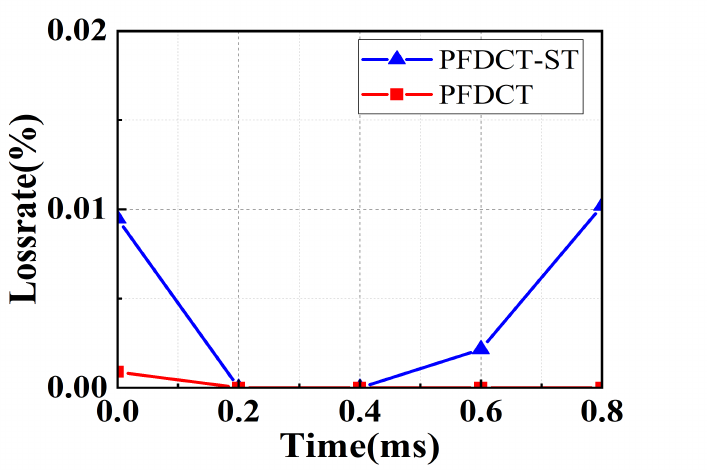
Figure 4. Loss rate comparison between PFDCT and